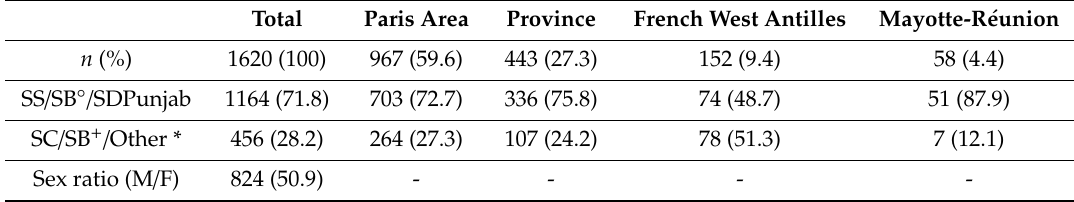
Table 1. General characteristics of the population.